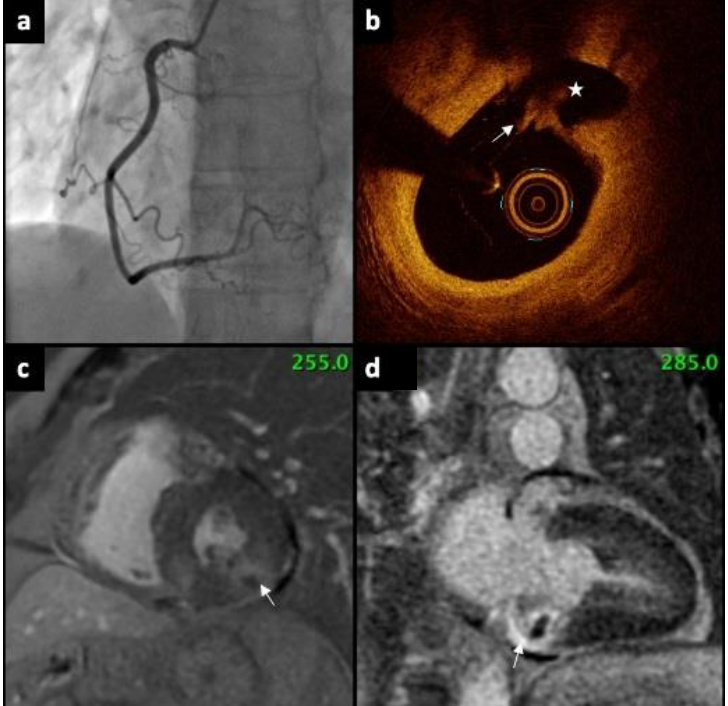
Figure 1. ( a ) Coronary angiography showing normal right coronary artery, without any stenosis. ( b ) OCT revealed ruptured plaque (arrow). Rupture cavity (asterisk) is formed behind fibrous cap disruption ( c ) CMR (short axis) presents subendocardial myocardial LGE (arrow). ( d ) CMR (LV two- chamber, long axis) demonstrate subendocardial scar in the basal segment of inferior wall (arrow).